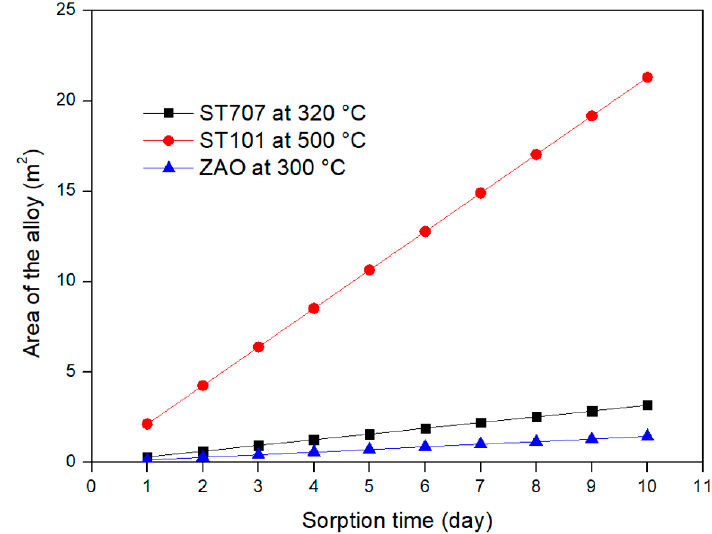
Figure 8. Area of the different alloys required for DEMO CPS application vs. sorption time.